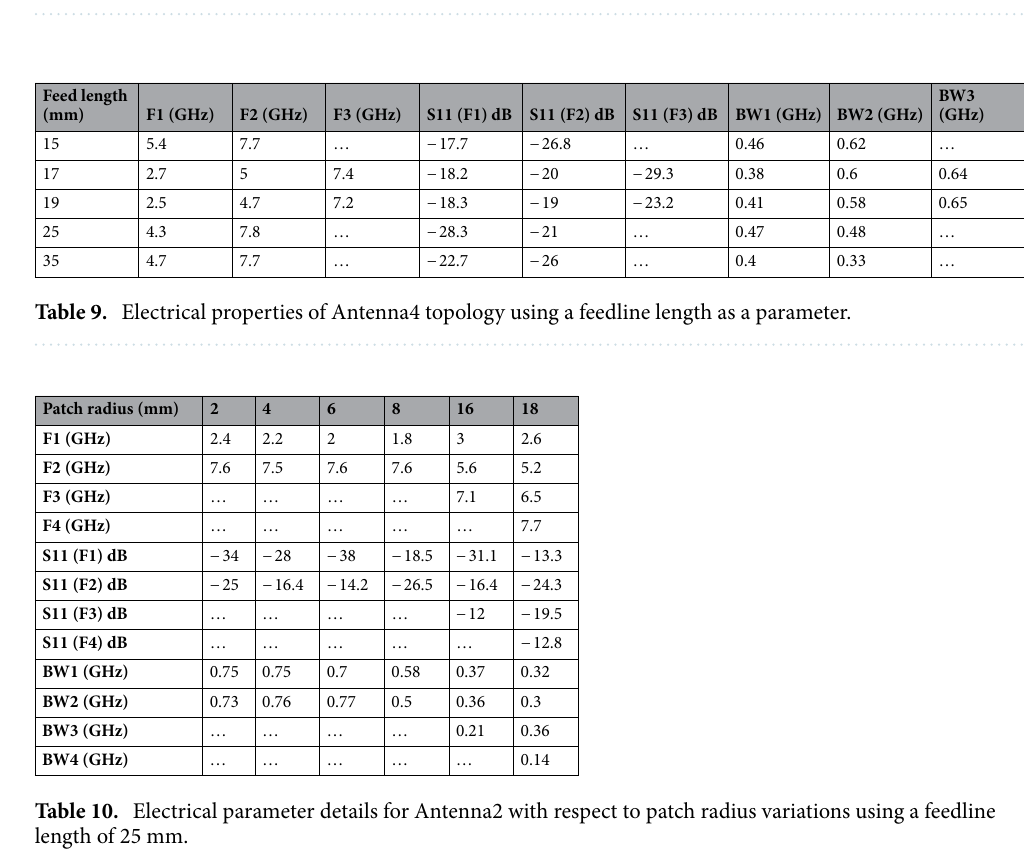
Table 8. Electrical properties of Antenna3 with a feedline length as a parameter.